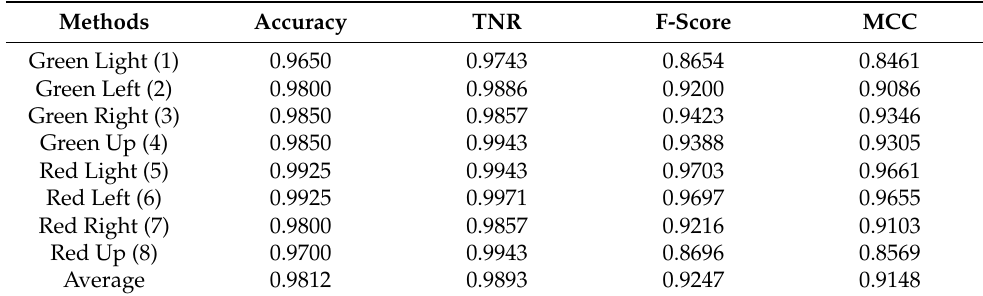
Table 6. Traffic signal classification results of CIWHO-ORC technique.